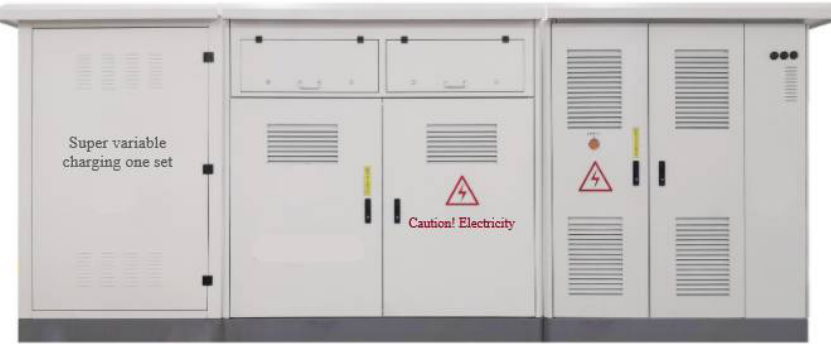
Figure 5. High-power IGBT type charging equipment.